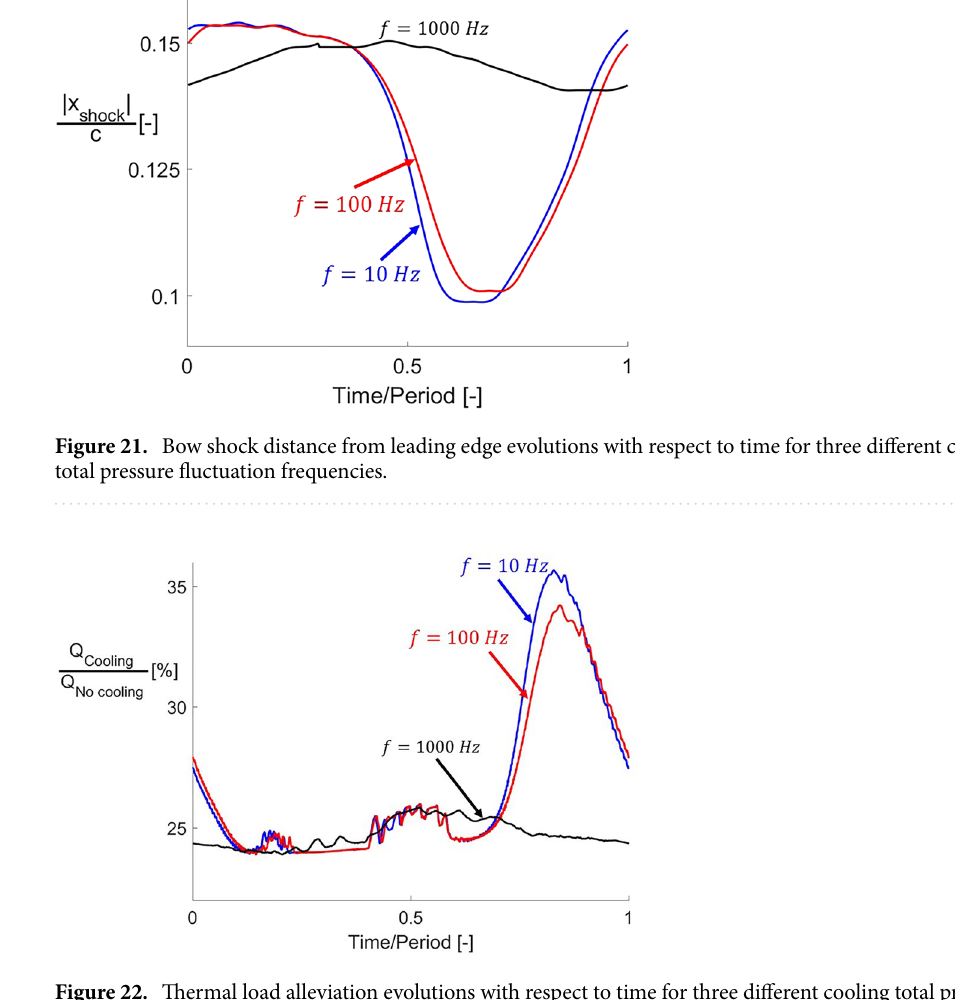
Figure 22. Thermal load alleviation evolutions with respect to time for three different cooling total pressure fluctuation